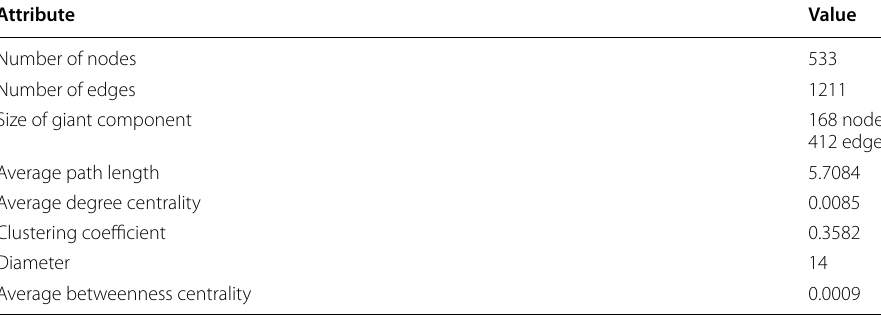
Table 4 Summary of similarity